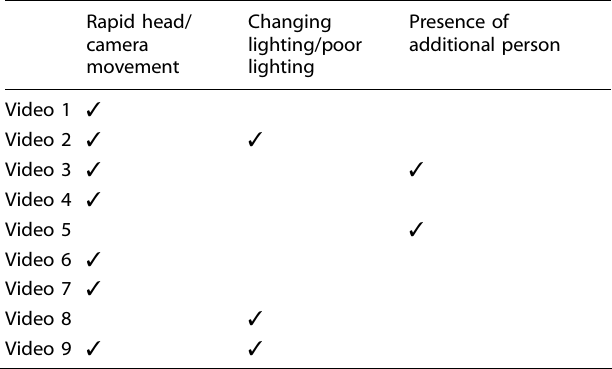
Table 7. Bland Altman error statistics of rPPG methods compared to the Masimo after the removal of outlier videos (in